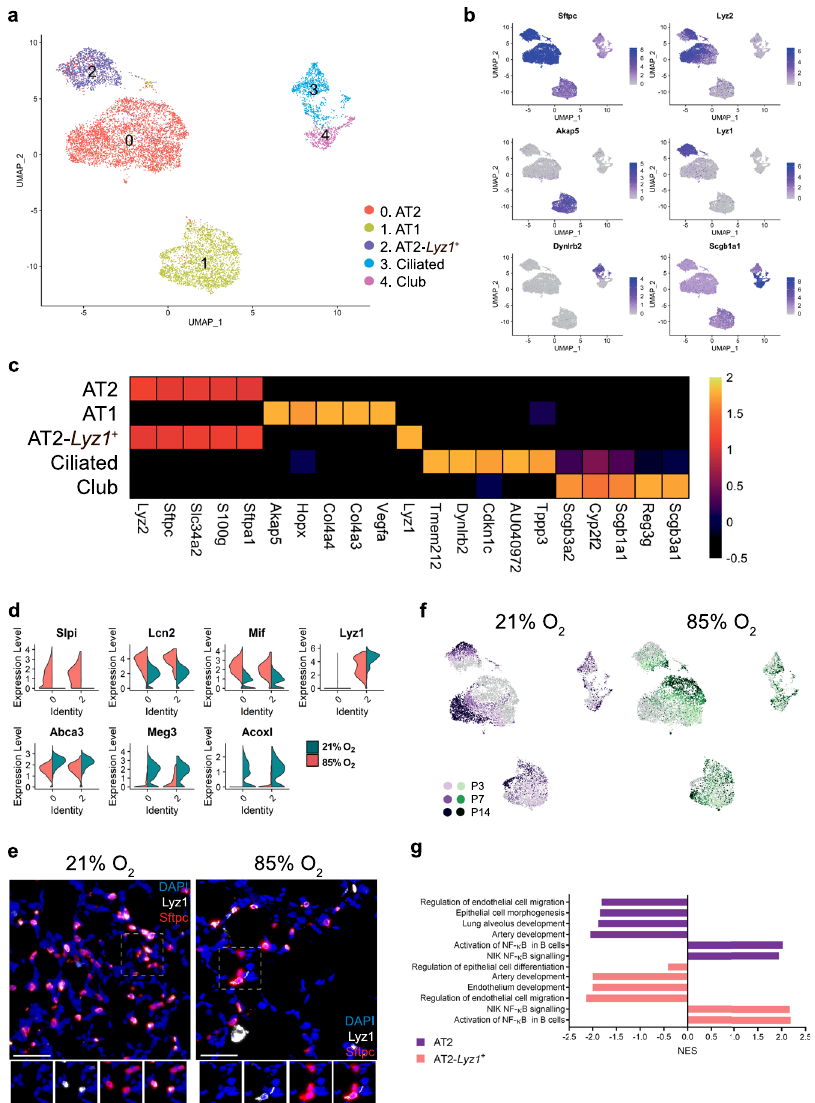
Fig. 3 Cellular composition of epithelial cells during normal and hyperoxia-impaired late murine lung development. a A total of fi ve clusters of epithelial cells were identi fi ed in developing lungs. Cell populations are colored as indicated by the legend. b UMAP plots showing expression of principal identi fi ers of different epithelial cell types. The intensity of expression is indicated by purple coloring. c Heatmap of top fi ve most differentially expressed genes across epithelial clusters. The intensity of expression is indicated as speci fi ed by the color legend. d Violin plots depicting changes in gene expression of some normoxia (21% O 2 , green) and hyperoxia-speci fi c (85% O 2 , red) genes in the two AT2 clusters at P14. e Representative images from fl uorescent RNA in situ hybridization for AT2- Lyz1 + marker Lyz1 (white) and pan-AT2 marker Sftpc (red) in developing mouse lungs. Magni fi cation: 40×. Scale bar = 40 µ m. Three 14-days old animals/group were analyzed. f UMAP plots depicting cell identity in regard to developmental time points in normally (purple) and aberrantly (green) developing lung epithelium. The intensity of expression is indicated as speci fi ed by the color legend. g Selected hyperoxia-impacted signaling pathways in AT2 (purple) and AT2- Lyz1 + (pink) clusters, as identi fi ed by gene set enrichment analysis (GSEA). All terms are signi fi cantly enriched (adjusted p value < 0.05) and normalized enrichment scores (NES) are shown. NES values were computed by gene set enrichment analysis on fold change-ranked genes. Expression values in Heatmap and violin plots represent Z -score-transformed log(TP10k + 1) values. Expression levels in UMAP plots are presented as log(TP10k + 1) values. Log(TP10k + 1) corresponds to log-transformed UMIs per